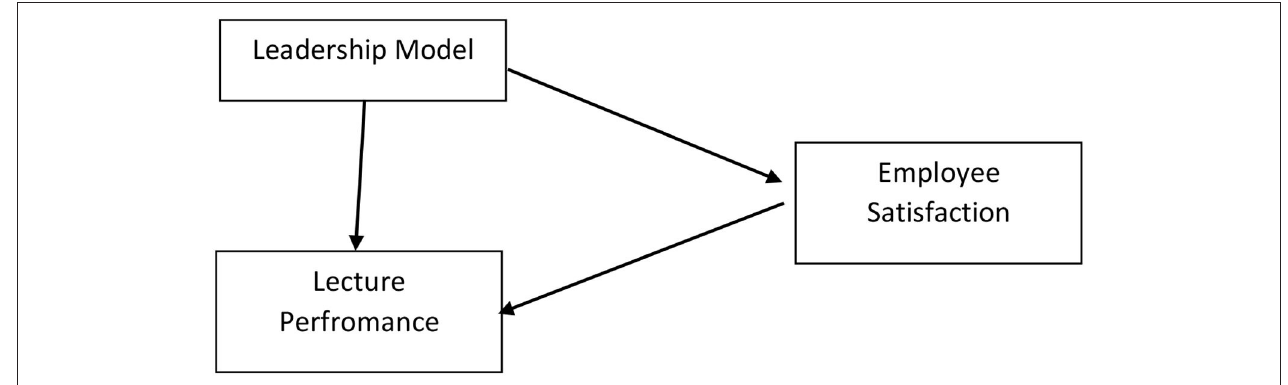
FIGURE 1 | Theoretical